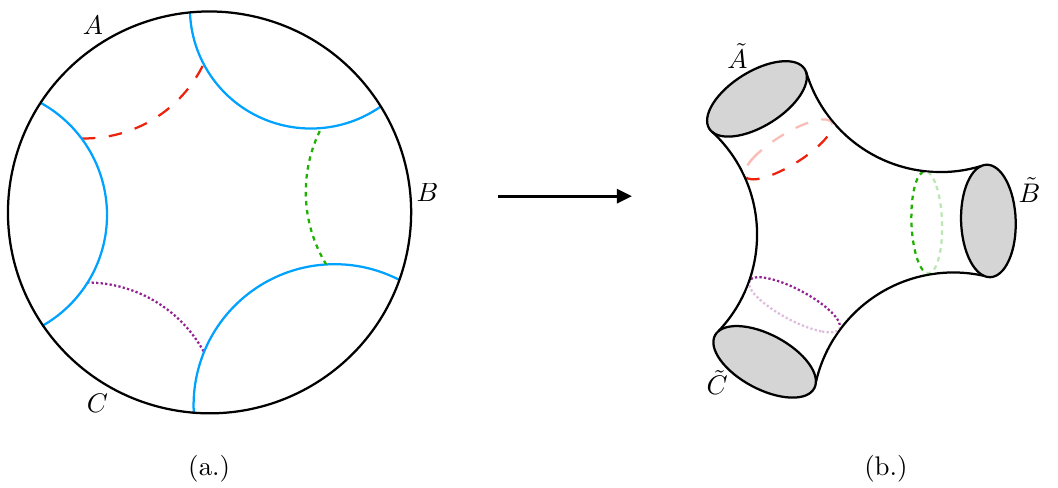
Figure 9 . The completely connected phase, where the entanglement wedge of ABC is a single connected region bounded by the blue Ryu-Takayanagi surfaces. The bipartite entanglement wedge cross sections (dashed lines) map onto wormhole throats in the quotient